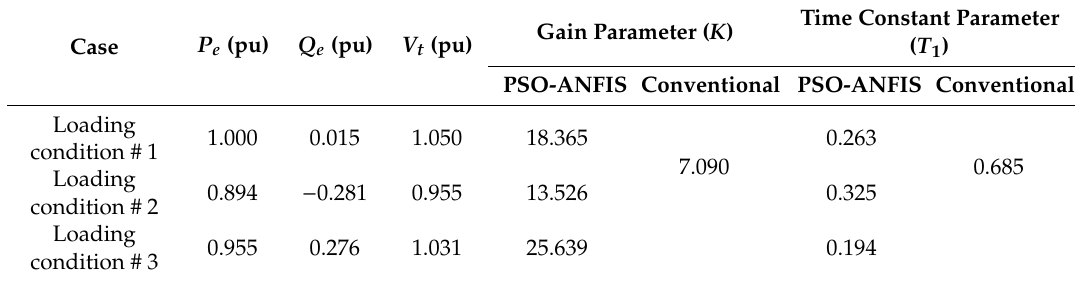
Table 6. Estimated PSS key parameters using the developed PSO-ANFIS models for three di ff erent operating situations (first network).